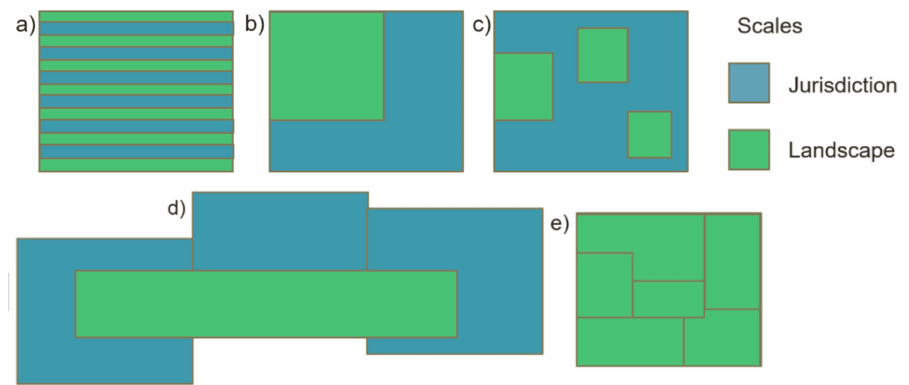
Figure 2. Interconnections between jurisdictional and landscape approaches (Source: own elaboration by authors). ( a ) The landscape itself is delimited within the political boundaries of the jurisdiction. The complete jurisdiction is the landscape where the landscape/jurisdictional approach is imple- mented. This situation is uncommon. ( b ) Inside the jurisdictional boundaries is one landscape where the resources to implement the approach are focused. ( c ) Inside the jurisdictional boundaries are two or more landscapes where the resources to implement the approach are focused. ( d ) The landscape touches more than one jurisdictional boundary. Therefore, the landscape approach in- cludes a multi-jurisdictional approach for its implementation; this can be an association of multiple neighboring municipalities, states, or even countries. ( b – d ) and are the most common cases of land- scape/jurisdictional approach implementation. ( e ) The complete jurisdiction is organized through a jurisdictional approach with nested landscapes or jurisdictional compacts at smaller scales, it’s a type of nested jurisdictional approach.